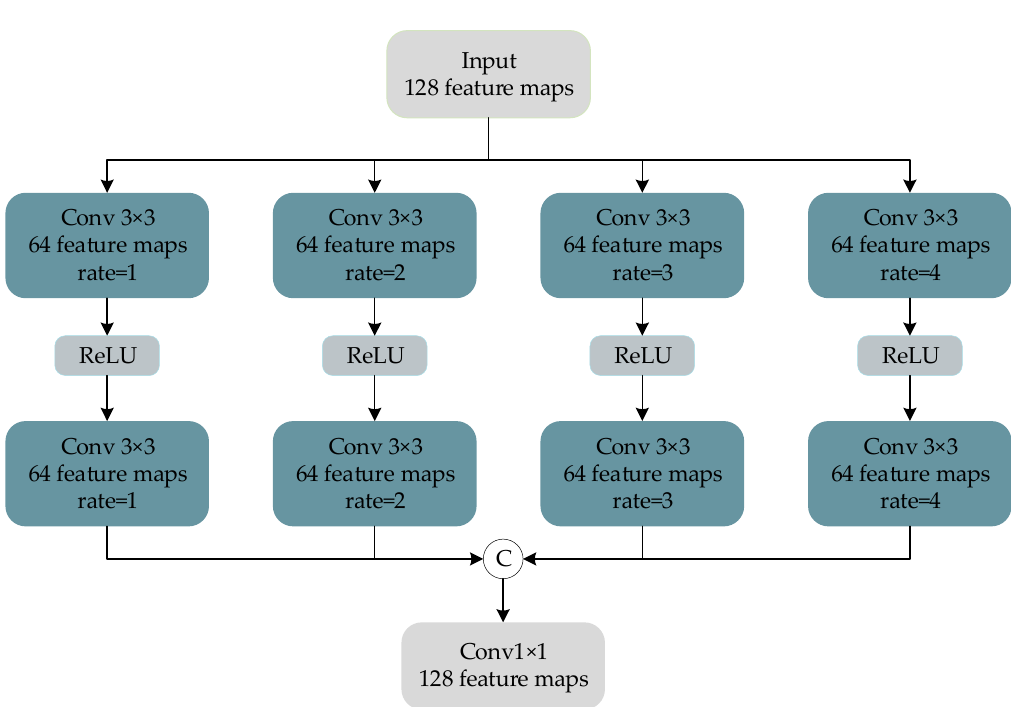
Remote Sens. 2021 , 13 , 535 Figure 4. Feature enhancement module structure. Figure 4. Feature enhancement module structure.